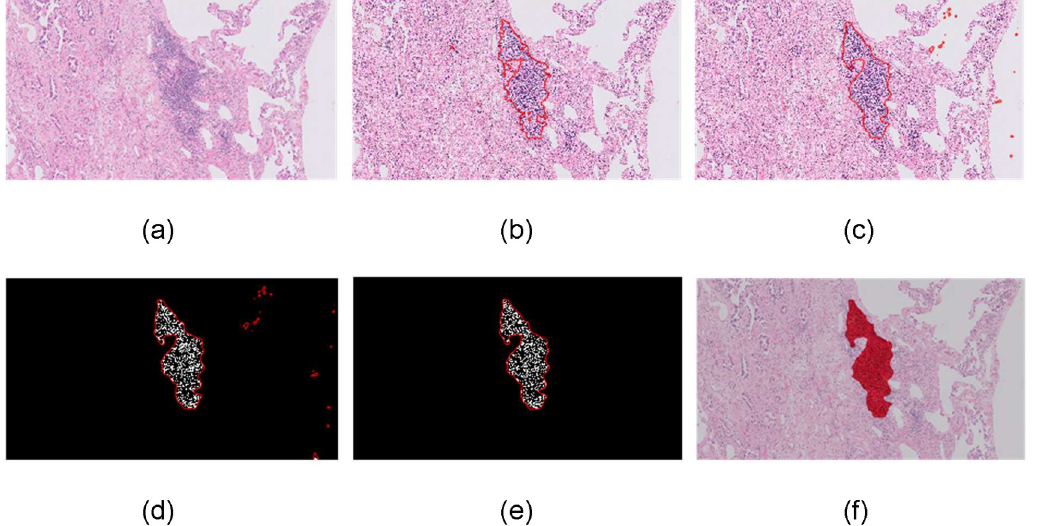
Fig 1. The proposed methodology for TLS detection. a) H&E images feed a DeepLab v3+ network, b) candidate TLS regions are identified, c) an active contour approach is applied for boundary refinement of the TLS regions, d) segmentation of lymphocytes is performed, e) post validation of TLS through rejection of candidate non-TLS regions, f) final detection of TLS regions.